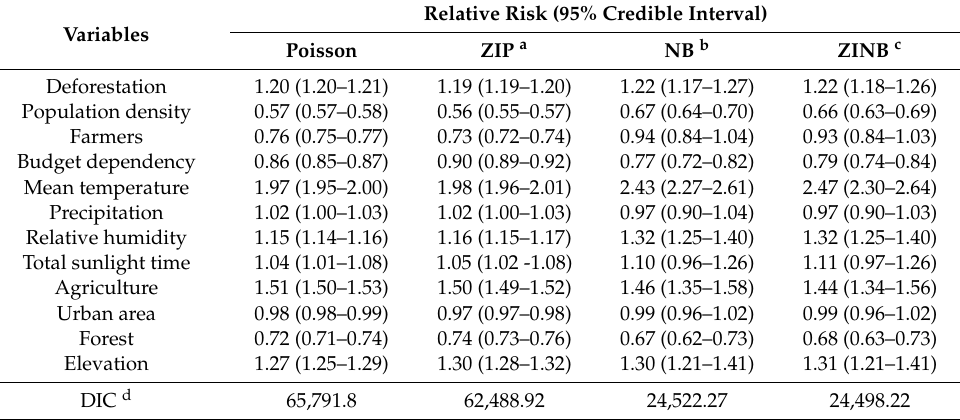
Table 3. Relative risks of scrub typhus by interquartile range increase for each explanatory variable from the non-spatial